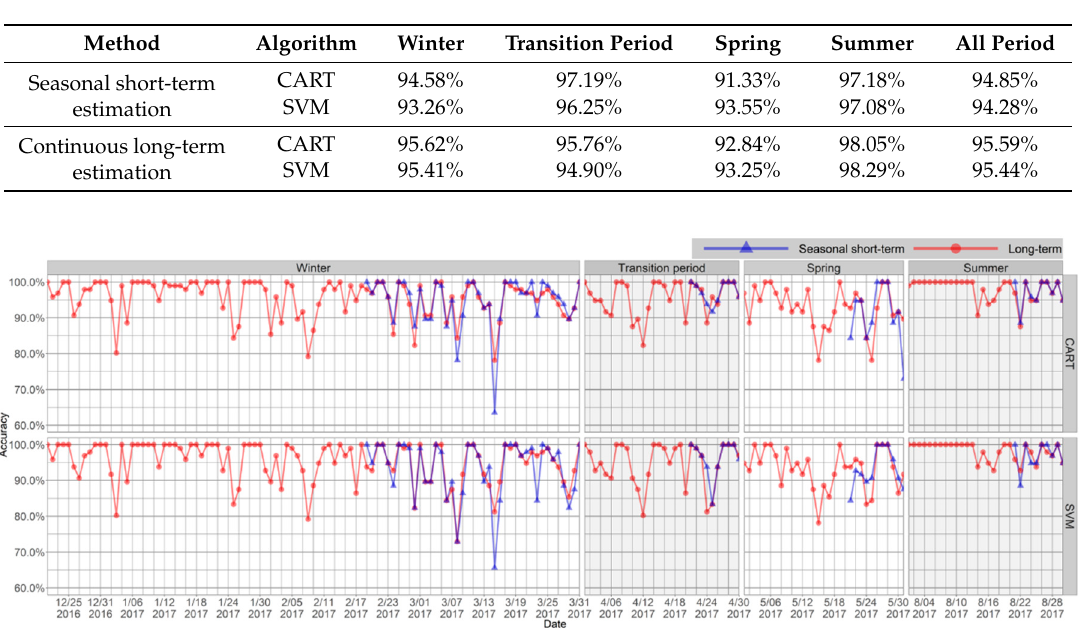
Table 10. Comparison of seasonal and overall accuracy between short-term and long-term occupancy estimation methods.